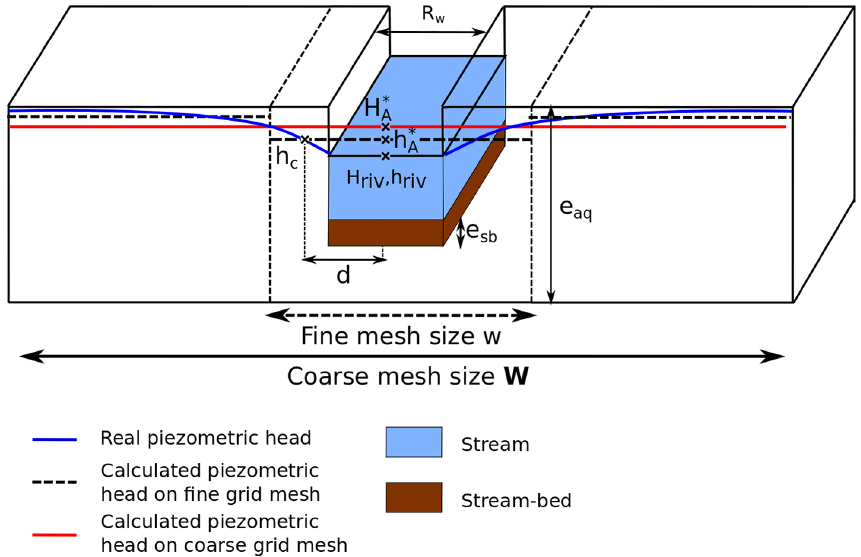
Figure 3. Scaling effects on averaged near-river piezometric